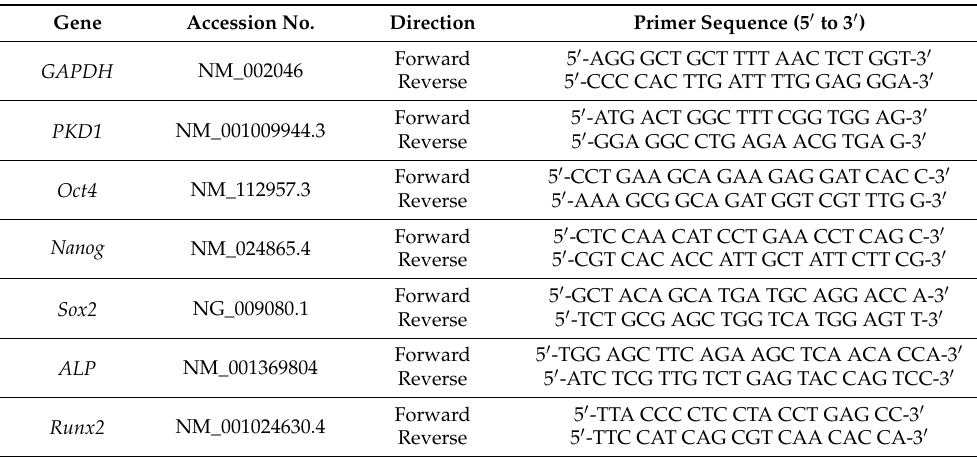
Table 1. Primer sequences used for PCR